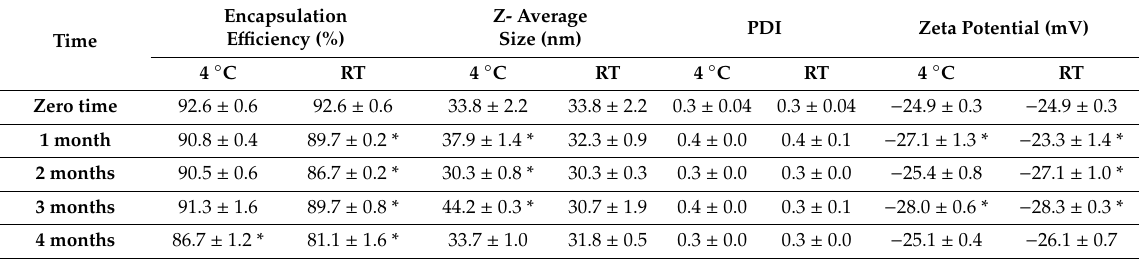
Table 2. E ff ect of storage time and temperature on the drug encapsulation e ffi ciency (%), particle size, polydispersity index and zeta potential of EGCG-GNPs formulation